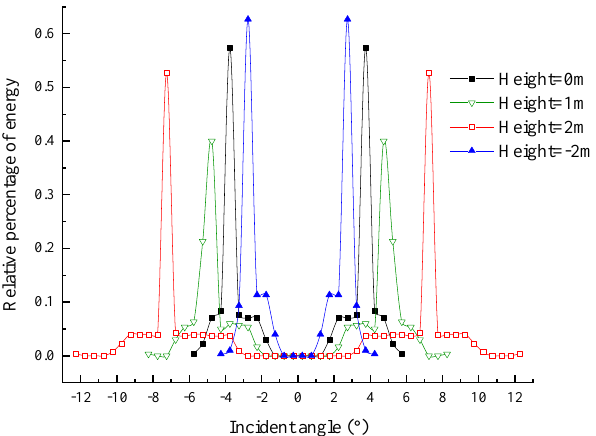
Figure 10. Comparison of the concentrated incident angles at different receiving heights.